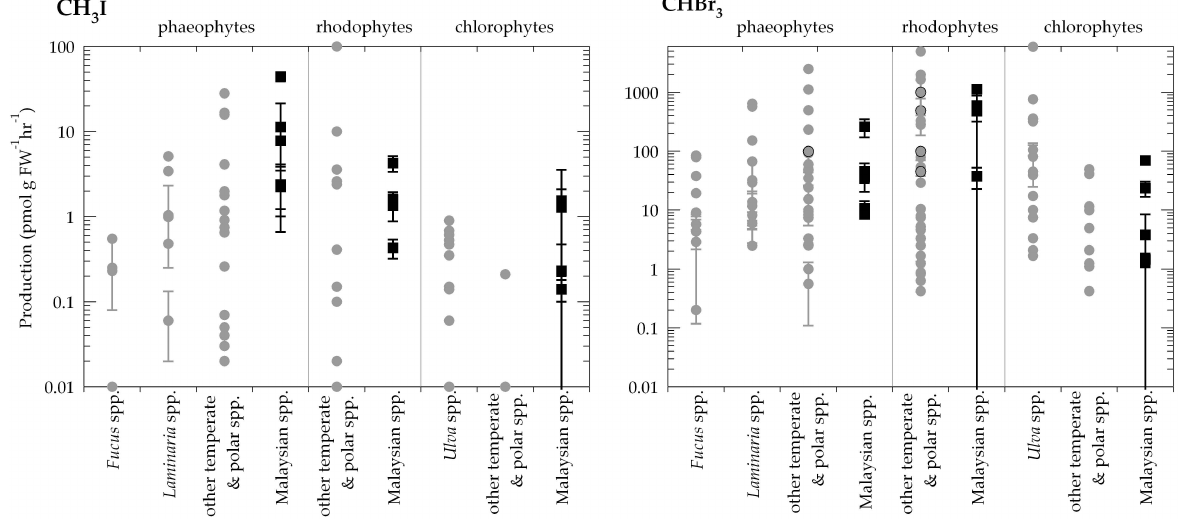
Fig. 6. Halocarbon production reported in this and previous studies for CH 3 I and CHBr 3 . (cid:4) =this study, error bars=1 σ standard deviation. • =previous studies (black outline=study may include subtropical or tropical strains). Values from the literature are commonly mean values from 2–3 replicates, sometimes the median was quoted. Error bars, where shown, are for standard deviation or range of production values. Published values were from the following sources: Baker et al. (2001); Bravo-Linares et al. (2010); Carpenter et al. (2000); Collen et al. (1994); Ekdahl et al. (1998); Giese et al. (1999); Goodwin et al. (1997); Gschwend et al. (1985); Itoh and Shinya (1994); Itoh et al.